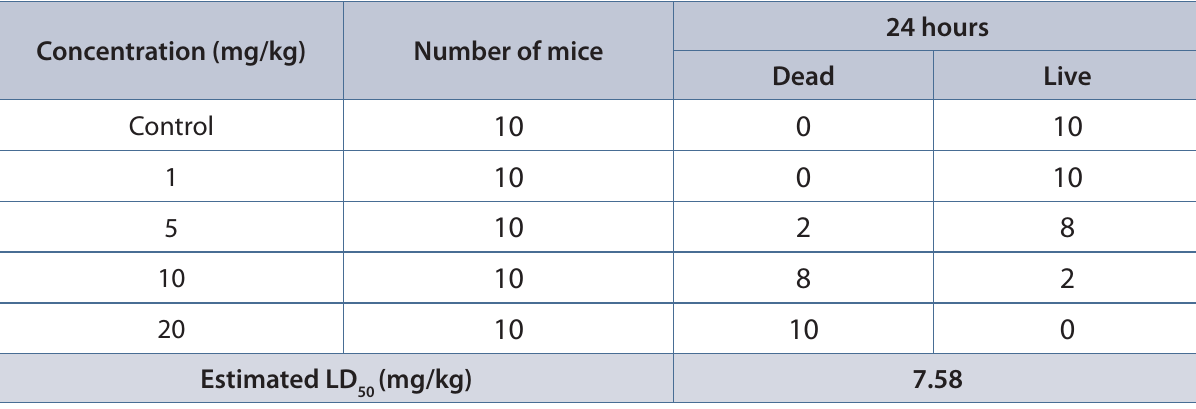
Table 1. Lethality of Macrovipera lebetina lebetina venom injected intraperitoneally into Swiss albino mice and estimated value of LD 50 Concentration